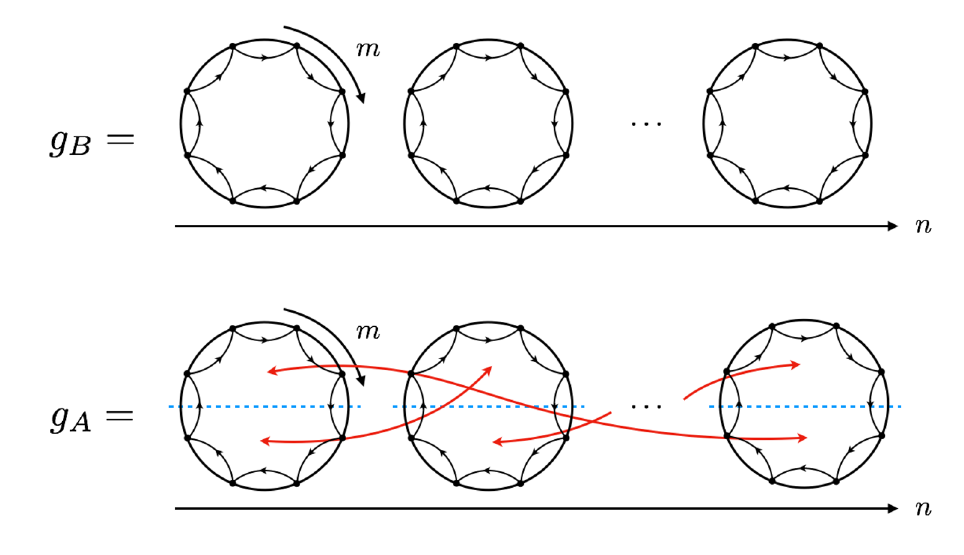
Figure 5 . A graphical representation of g A and g B . The individual circles each represents the m replicas of the original tensor and each of the circles is further replicated n times. Going clockwise in each circle increases the m replica number and going to the next circle on the right increases the n replica number. A cycle of the permutation is represented by a closed directed loop. The element g A can be thought of as cutting open the m -circles of g B from the middle, shifting the bottom half cyclically in the n direction (as the red arrows) and then gluing them back